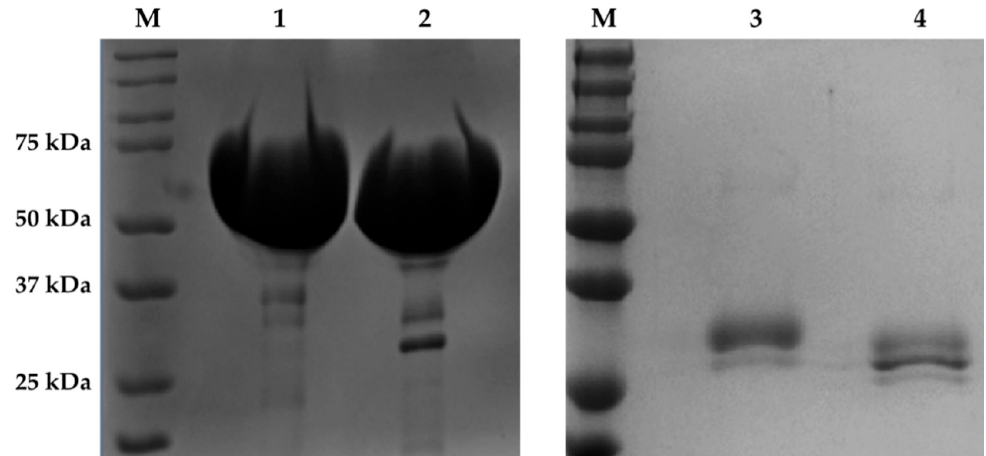
Figure 1. SDS-PAGE (10% polyacrylamide gel) analysis of the purified recombinant Af Cel6A and Af AA9_B. Lane M, molecular mass standards (Precision™ Protein Standards Dual Color—BioRad); lane 1, purified recombinant Af Cel6A; lane 2, deglycosylated Af Cel6A; lane 3, purified recombinant Af AA9_B; lane 4, deglycosylated Af AA9_B. We excised the purified Af AA9_B from the gel and analyzed it on the LC-MS/MS Xevo TQS (Waters) system at the Multi-User Laboratory of Mass Spectrometry, which confirmed that the enzyme was LPMO (Table 1). Table 1. Peptide sequences.